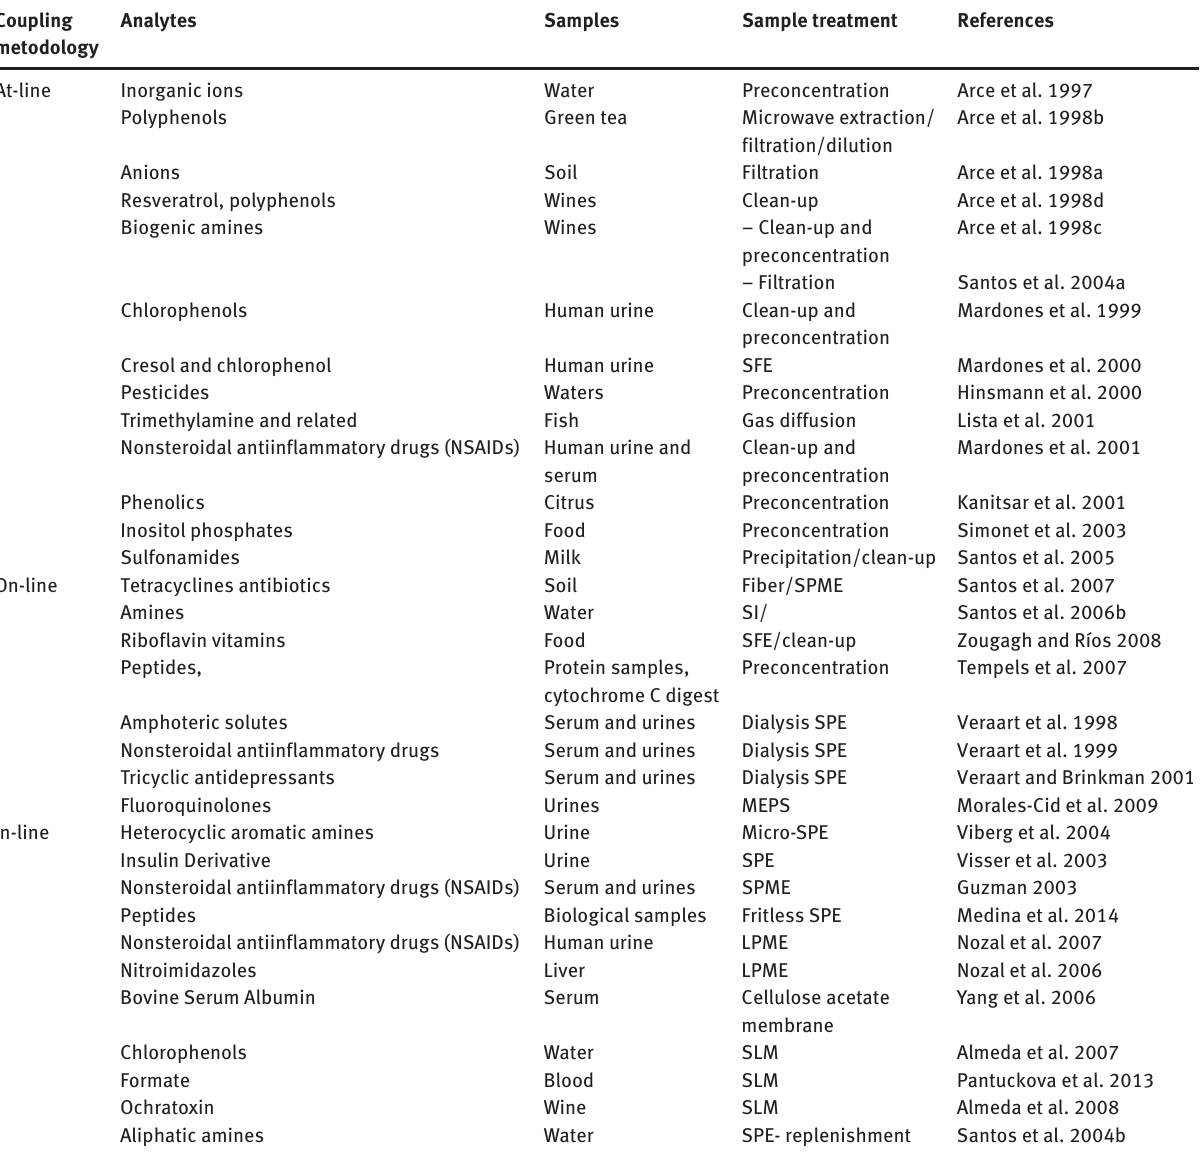
Table 1 Sample-treatment devices coupled at-line, on-line and in-line to commercial CE equipment.